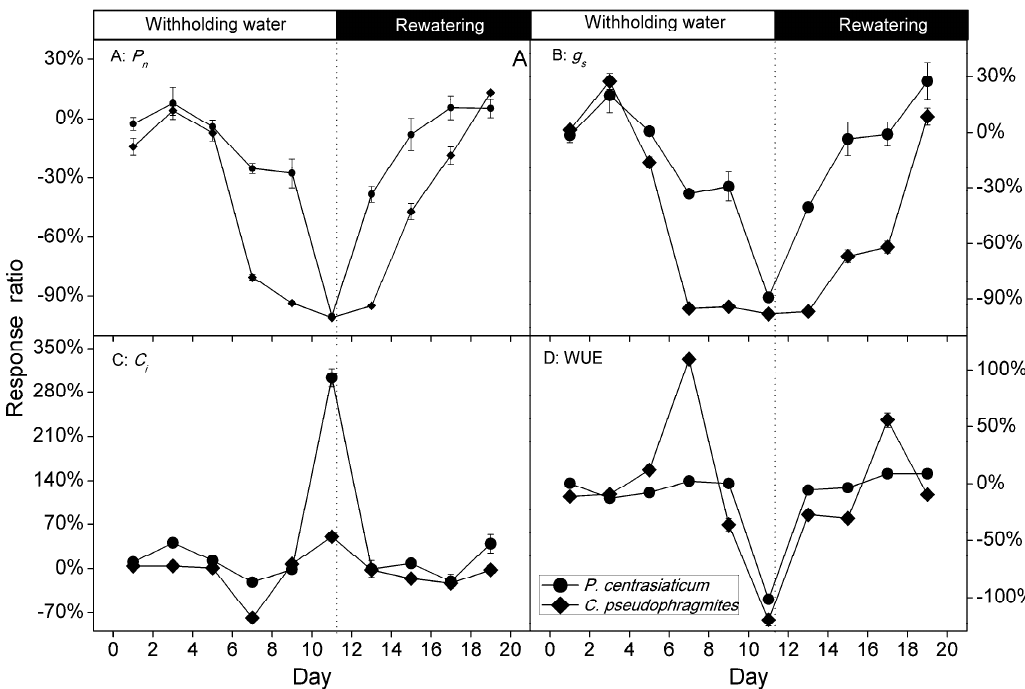
Figure 4. Changes of responses ratio in leaf net photosynthetic rate ( P n ), stomatal conductance ( g s ), intercellular CO 2 concentration ( C i ) and water use efficiency (WUE) during soil drought and rewatering for P. centrasiaticum (C 4 ) and C. pseudophragmites (C 3 ), respectively. Filled circles ( ● ) and diamond ( ♦ ) denote P. centrasiaticum and C. pseudophragmites respectively. The beginning of rewatering is indicated by the dotted line.